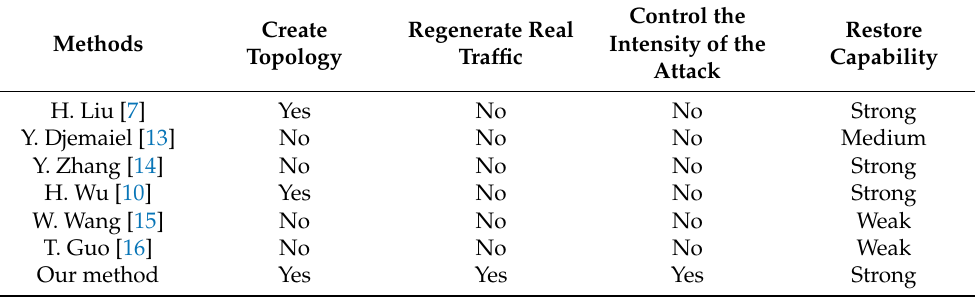
Table 7. Qualitative Analysis